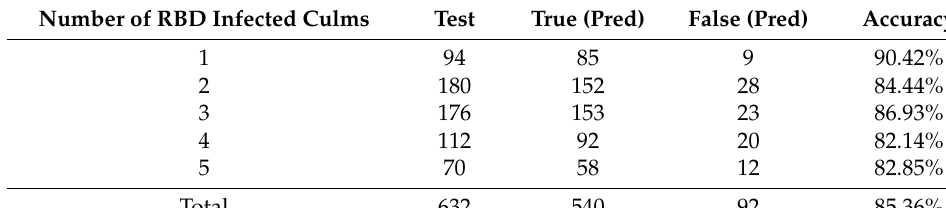
Table 12. Culm number classification performance results for deep residual network 101.